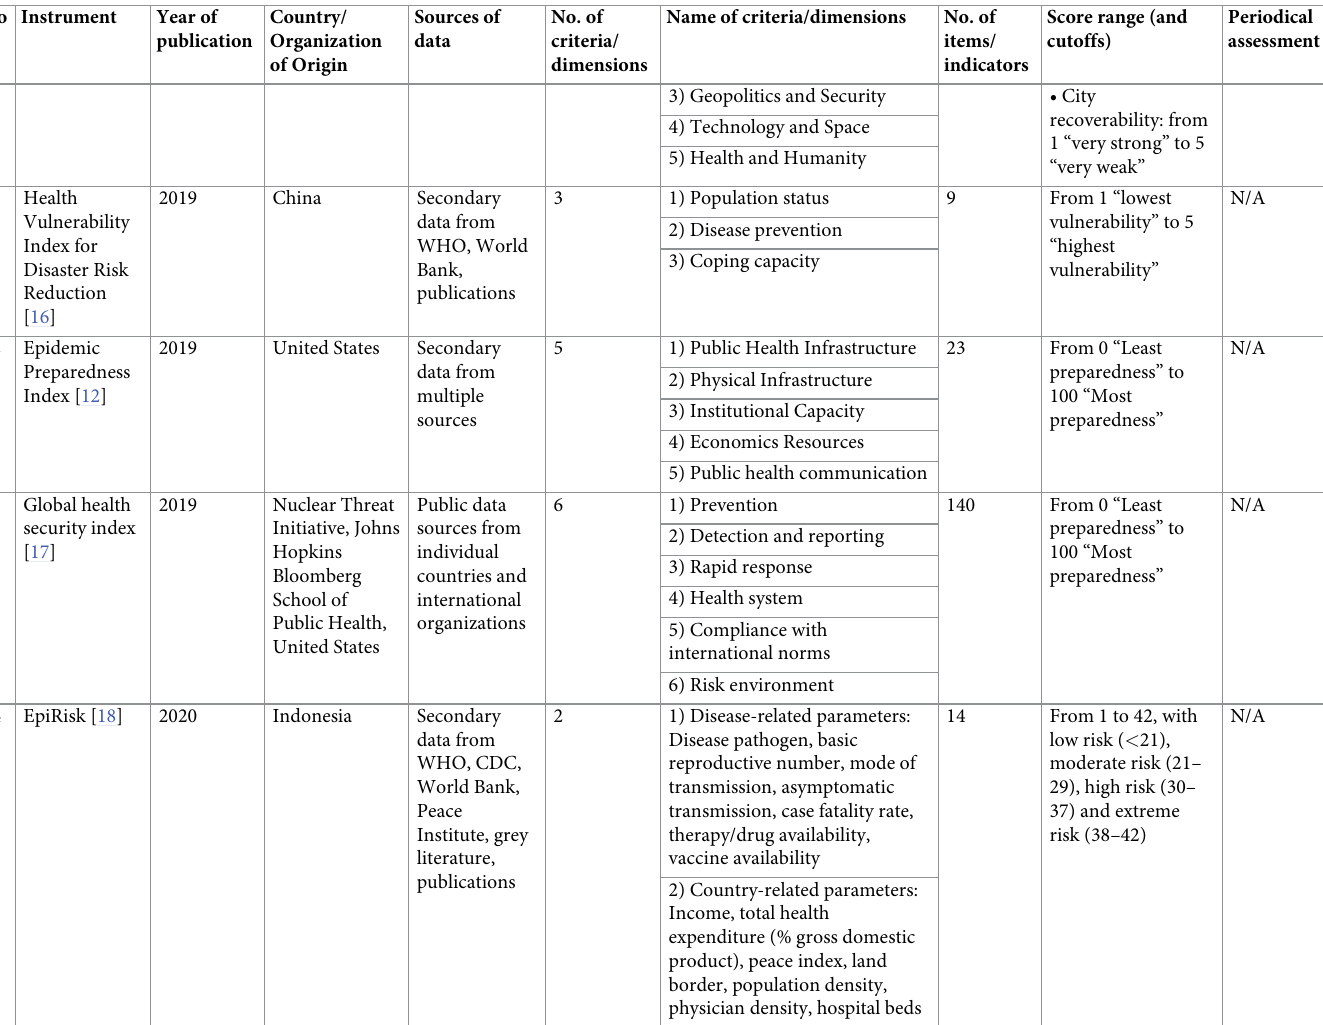
toolkits determined that they covered the national level except CDC’s Social Vulnerability Index. Six of the instruments measured preparedness in epidemic and/or natural disasters (in which epidemic risk assessment was one of the components), and others measured the risk